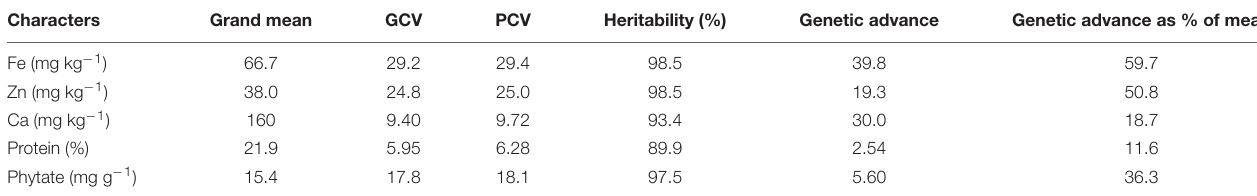
FIGURE 1 | Mean value of five highest and lowest accession of Vigna stipulacea regarding nutrients and antinutrient concentration in grain. (A) Fe concentrations at Loc1 and Loc2. (B) Zn concentrations at Loc1 and Loc2. (C) Ca concentrations at Loc1 and Loc2. (D) Protein concentrations at Loc1 and Loc2. (E) Phytate concentrations at Loc1 and Loc2. TABLE 2 | Descriptive statistics regarding grain nutrients [Fe, Zn, Ca, and protein, and antinutrient (phytate)] concentration of Vigna stipulacea .